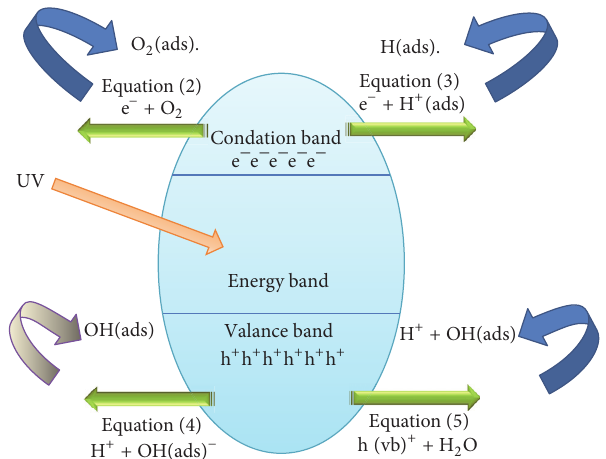
Figure 3: The mechanism of photocatalysis on TiO 2 nanomaterials